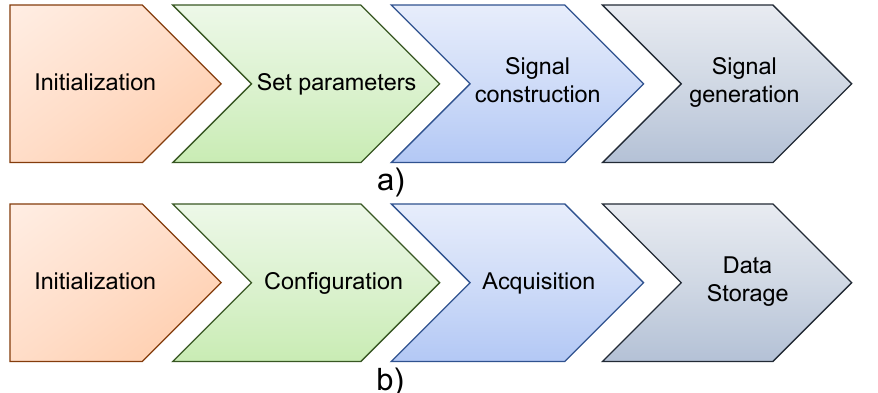
Figure 4. Scheme for: ( a ) Signal generator. ( b ) Data acquisition system.